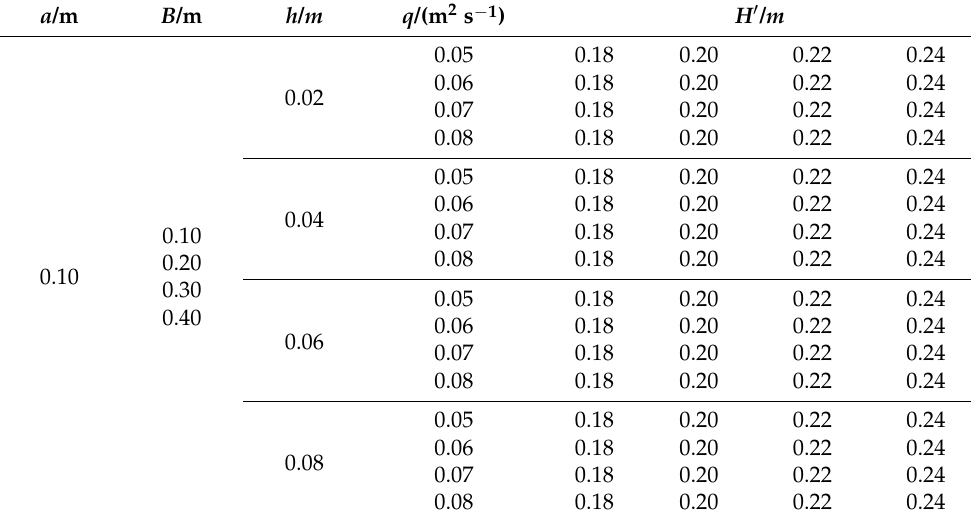
Table 1. Experimental parameters.